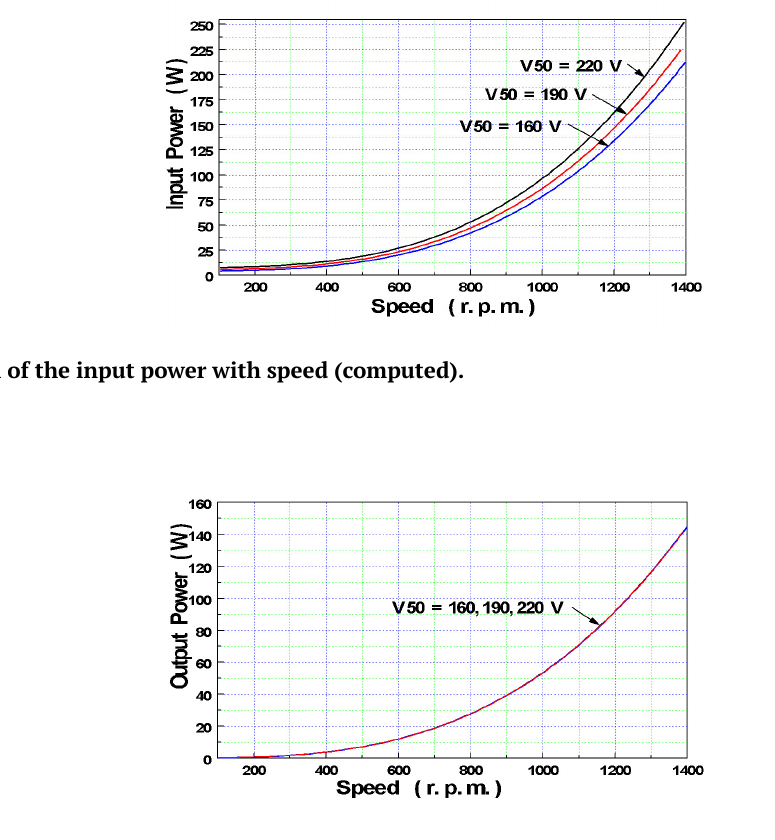
Fig. 7. Variation of output power with rotor speed (Computed).